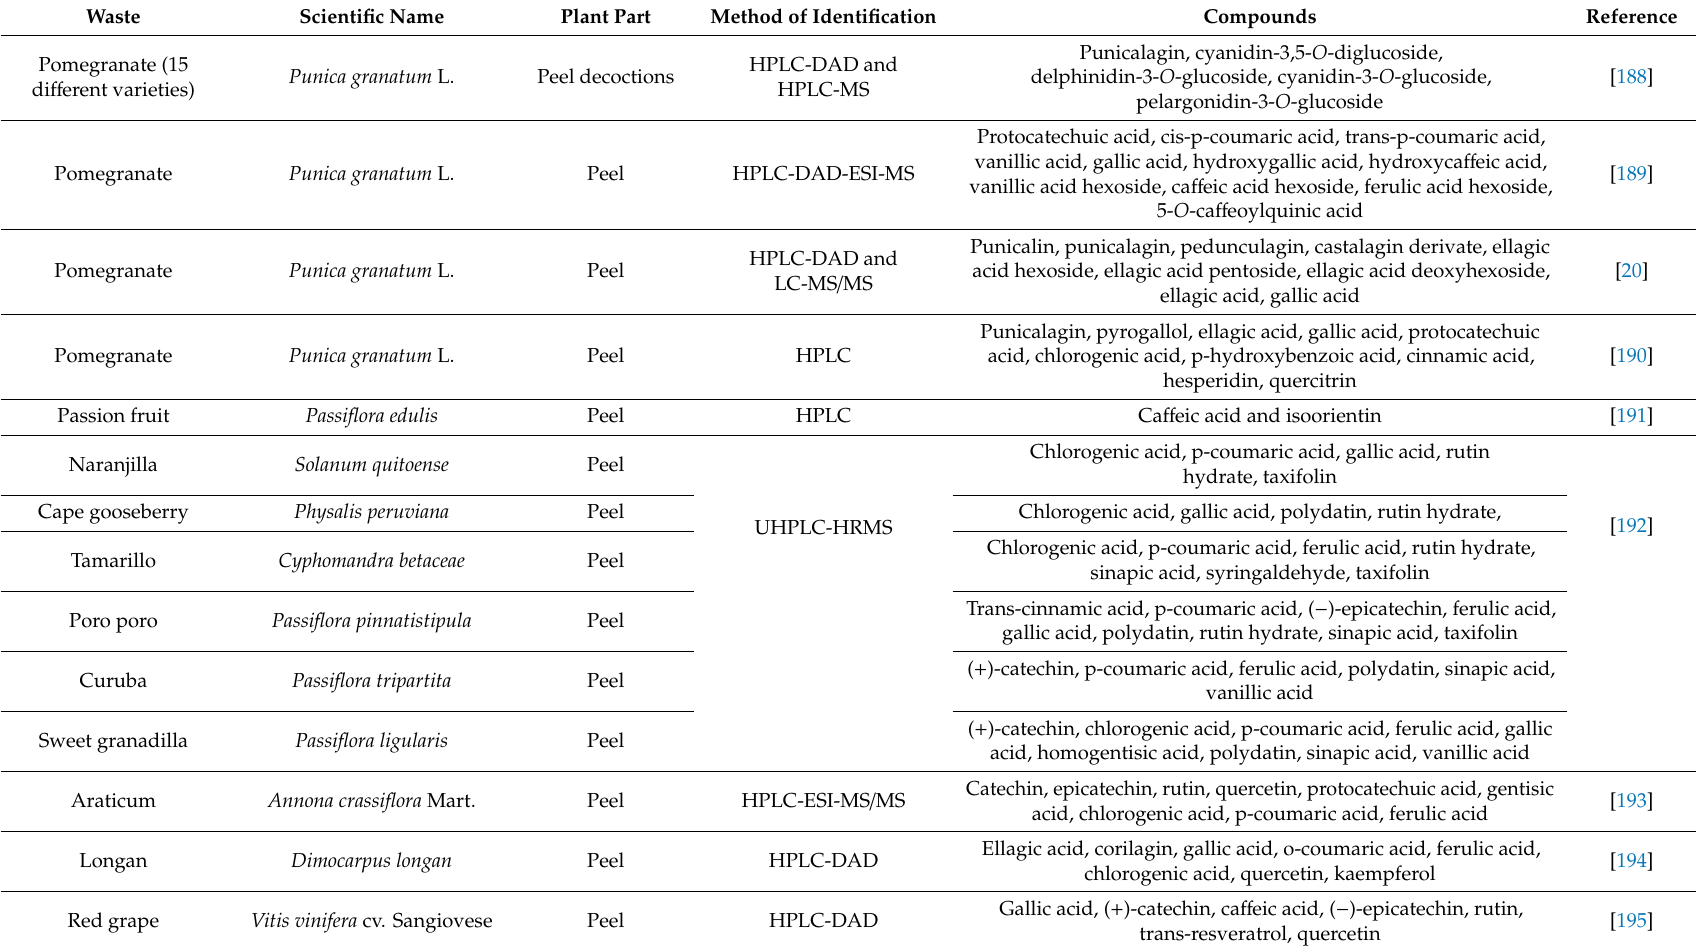
Table 4. Phytochemicals found in vegetable waste with antidiabetic and anti-obesity